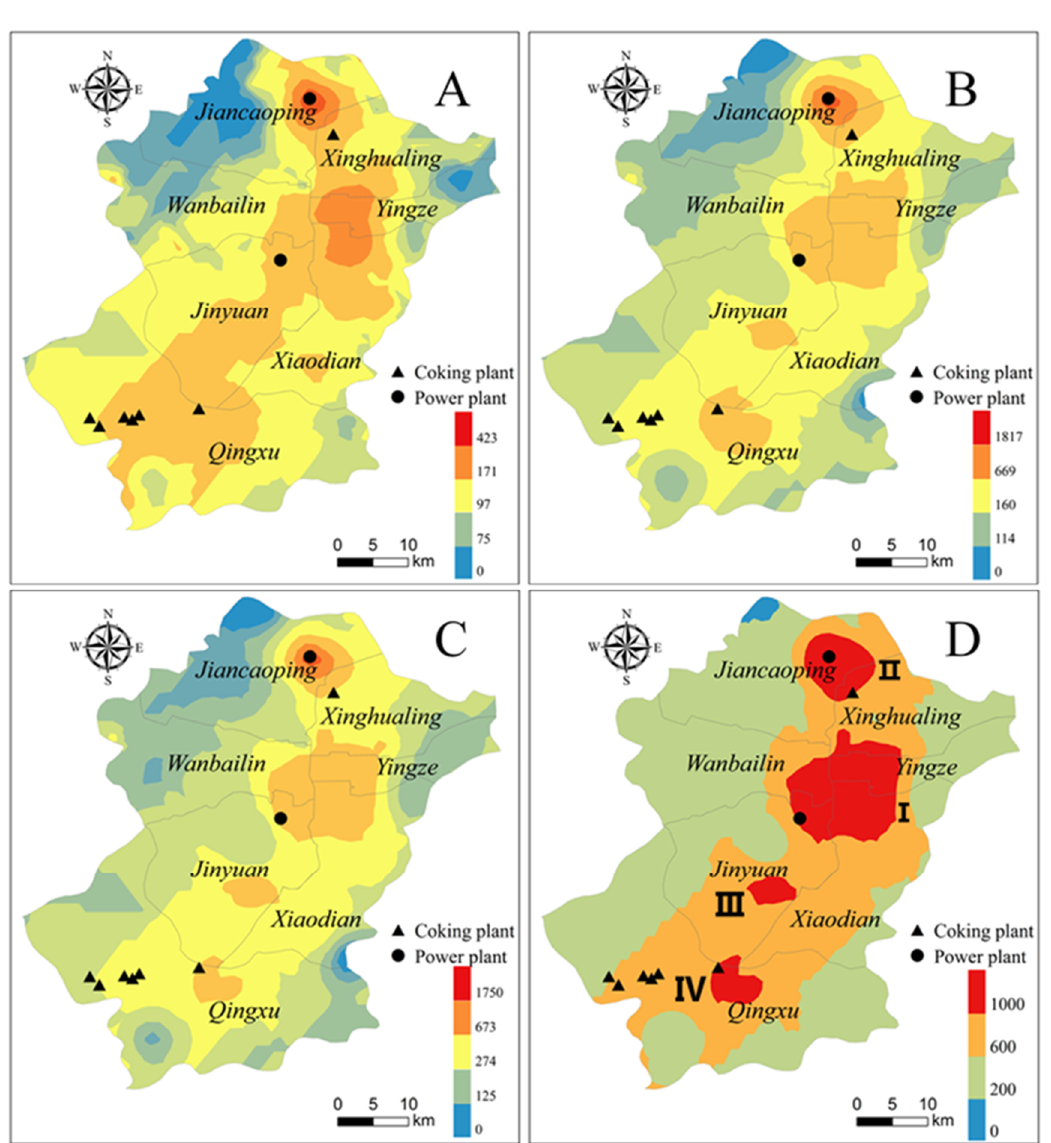
(cid:80) 16PAHs ( D ). LMW: